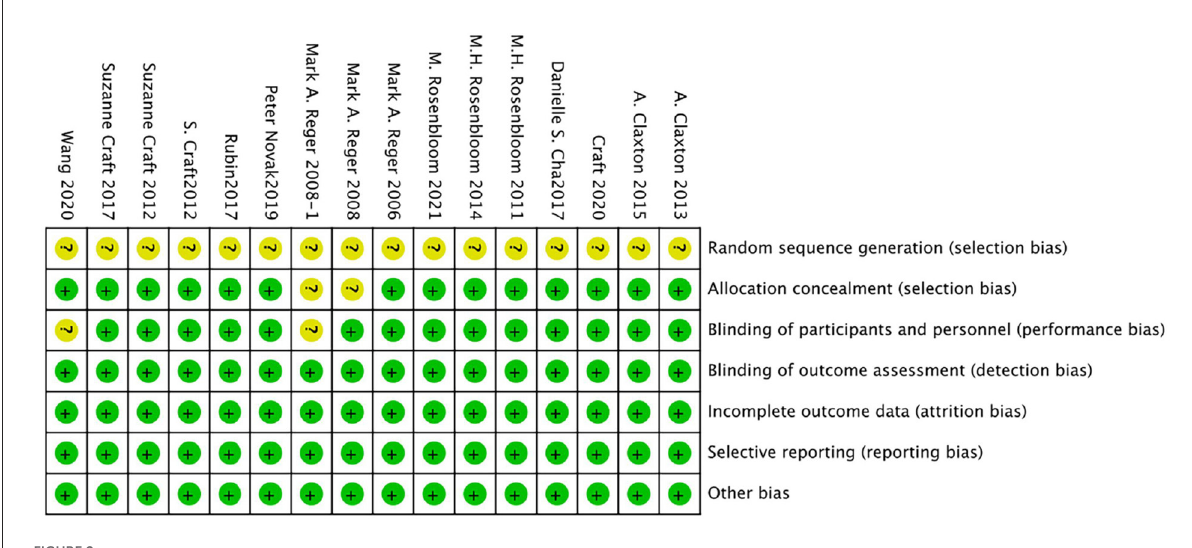
FIGURE2 Risk of bias summary for each risk of bias item for each included study.